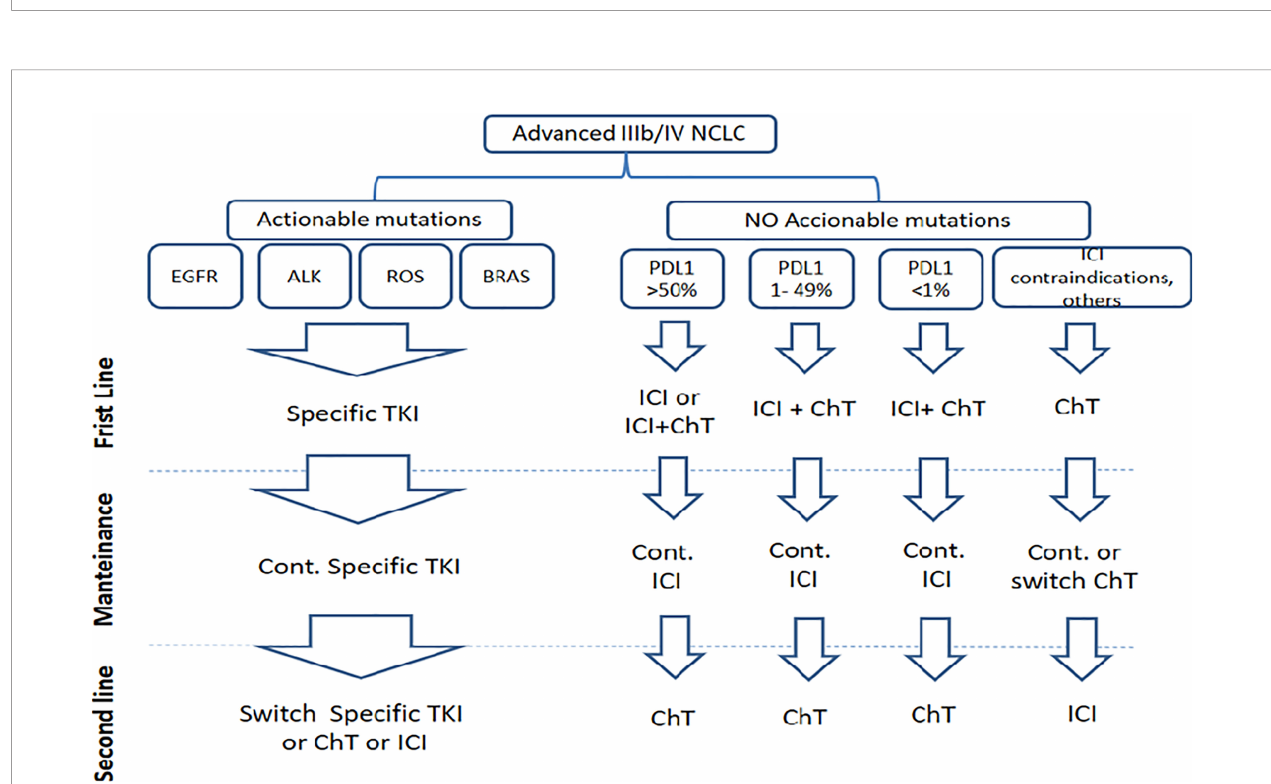
FIGURE 5 | Current landscape of NSCLC according actionable mutations and PD-L1